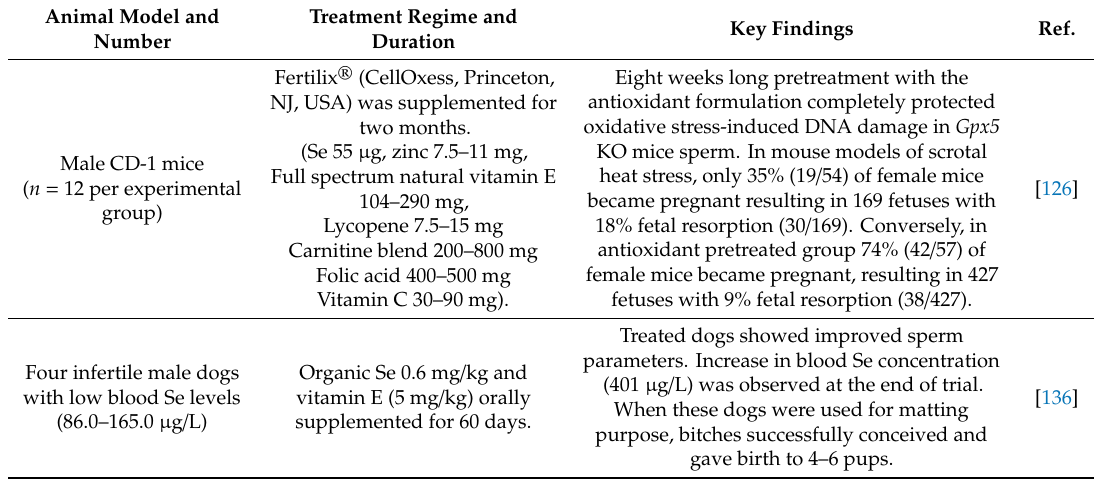
Table 5. Recent animal studies reporting the implication of selenium supplementation (in combination with other micronutrients) on male fertility